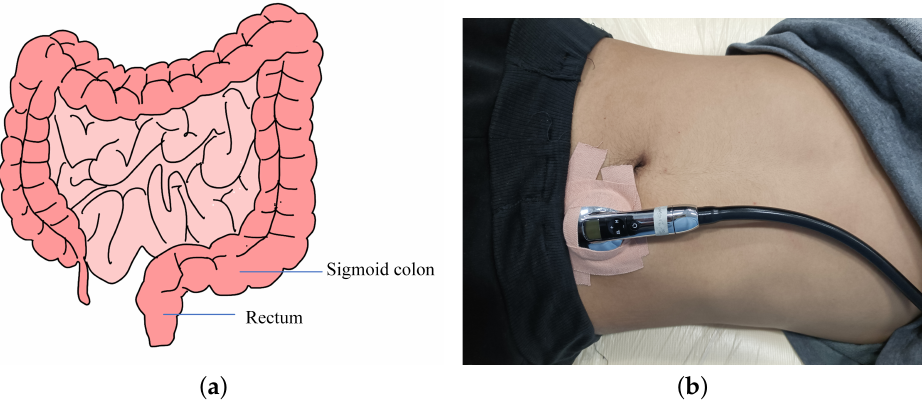
Figure 5. ( a ) Schematic diagram of the intestinal tract. ( b ) Schematic diagram of bowel sound signal